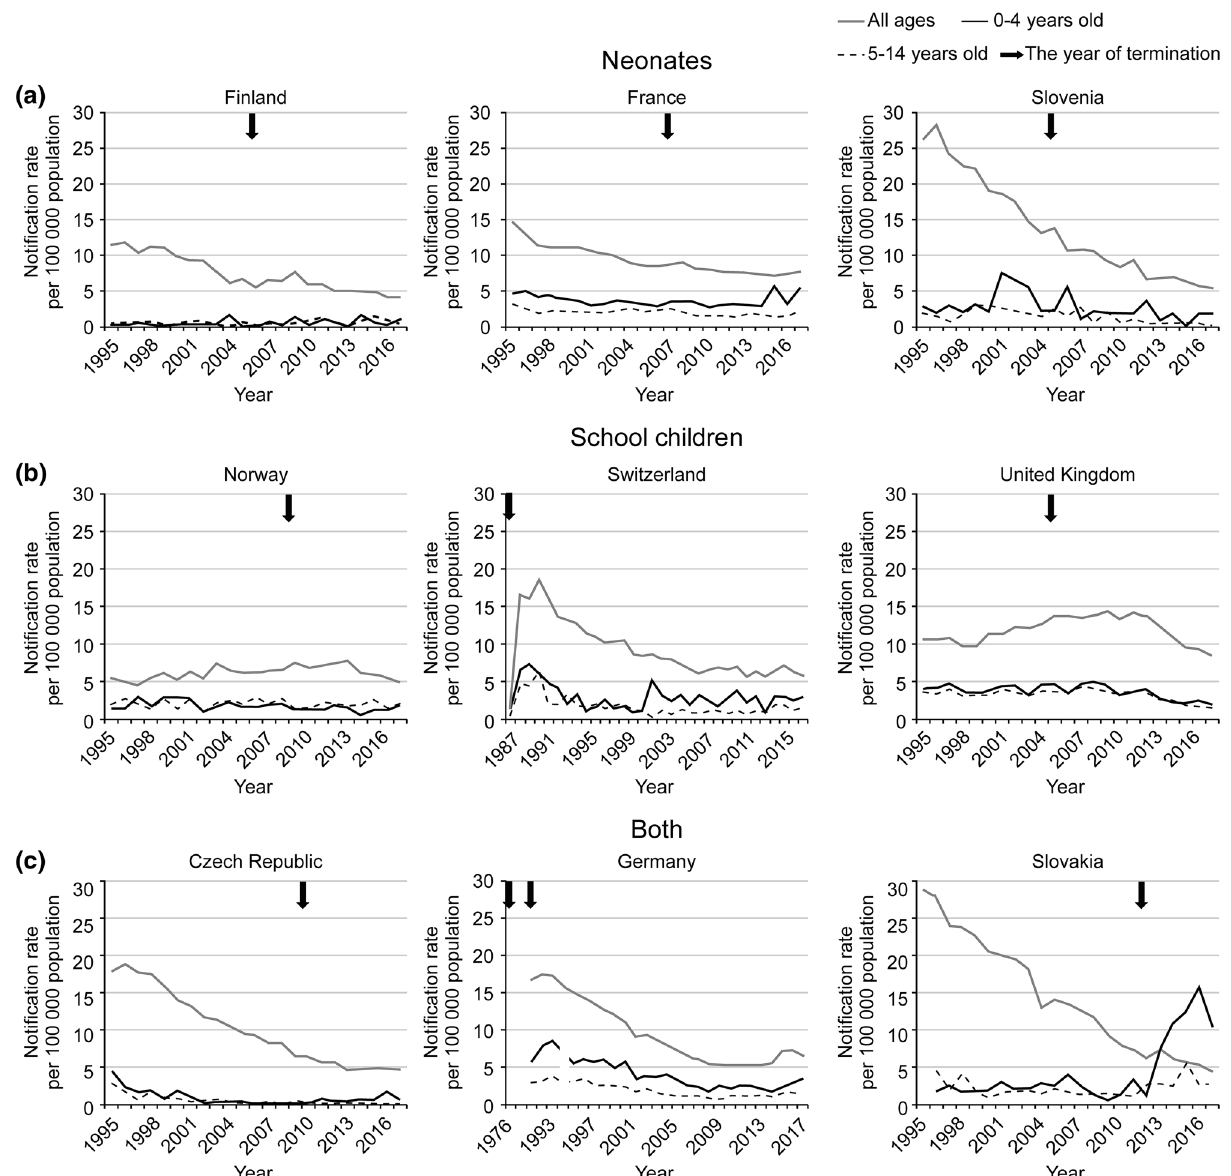
Figure 1. Trends in tuberculosis notification rate (all forms; all ages, 0–4 years, and 5–14 years). *Data sources: ECDC data (the Czech Republic, Finland, France, Germany (1995–2017), Norway, Slovakia, Slovenia and the UK) (https:// www. ecdc. europa. eu/ en/ surve illan ce- and- disea se- data), The Germany Federal Health Monitoring System (1991–1994) (http:// www. gbe- bund. de/ stich worte/ Tuber kulose. html), and the Swiss Federal Office of Public Health. † TB notification rate per 100,000 population. ‡ Figures are categorised into three groups by the target age of BCG vaccination (a: neonates, b: school children, c: both neonates and school children), and the arrow in figures shows the year of cessation. § The data from 1991 to 1994 in Germany include different age distributions (1–4 and 5–15 years). Abbreviations: Bacillus Calmette–Guérin (BCG); United Kingdom